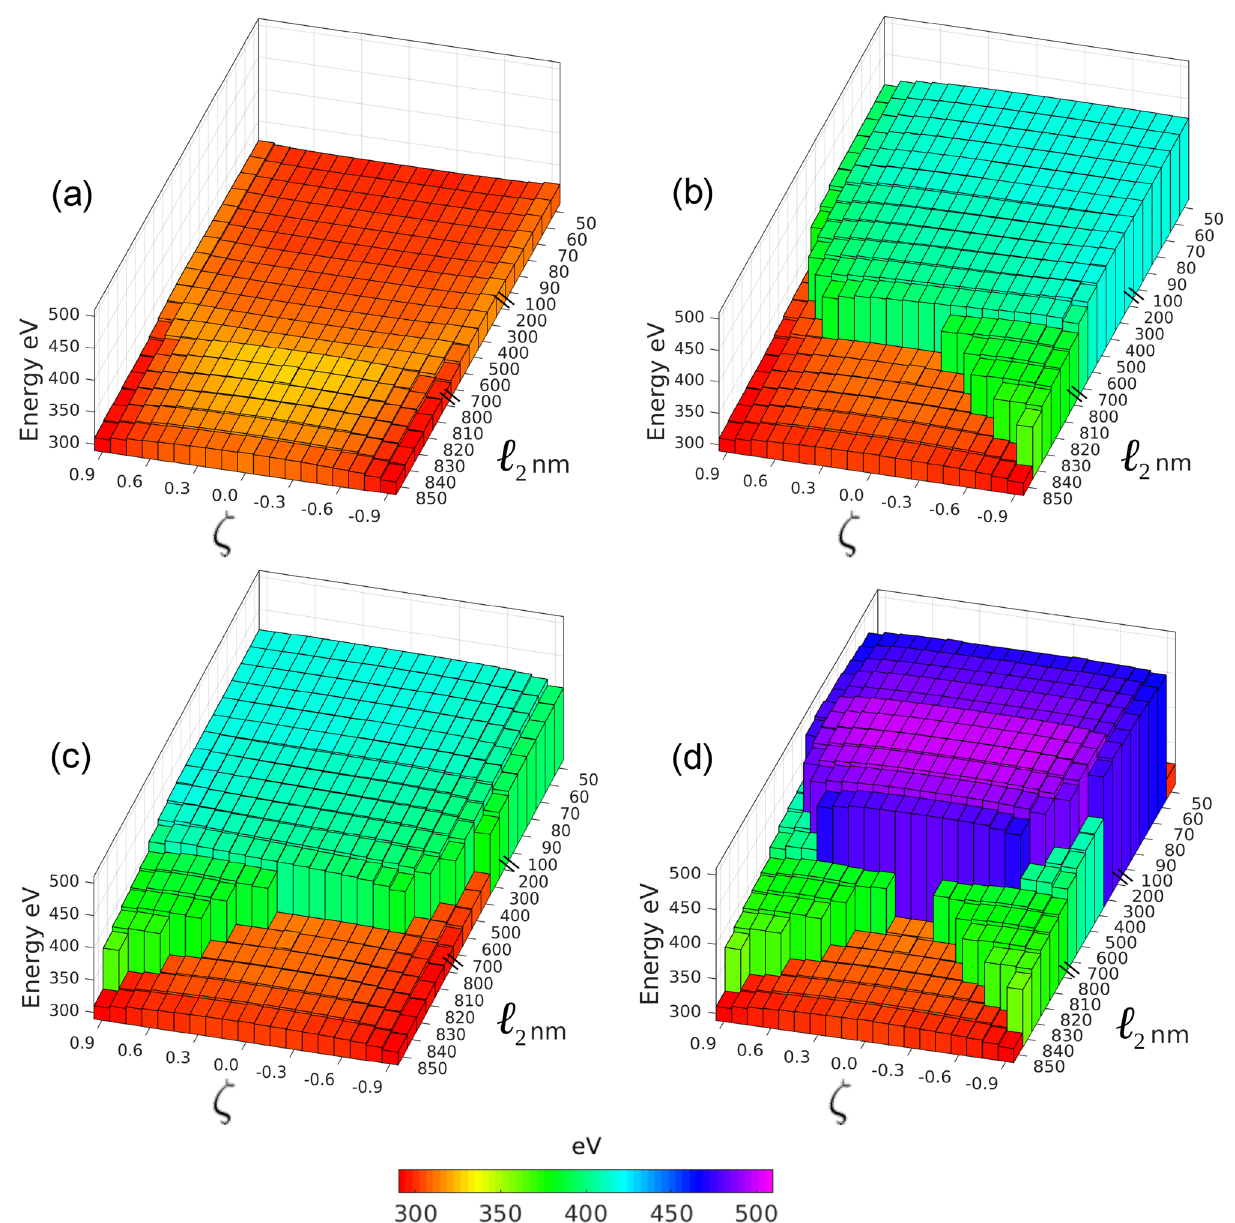
Figure 3. Energy phase diagram testing stability of the inscribed information. Each pixel represents a different ℓ 1 , ℓ 2 and ℓ 3 (through ζ ) choice and the height gives the corresponding equilibrium or final energy. Panel (a) illustrates the equilibrium energy for an original configuration C 1 inscribed in the system: obviously here it remains in the true ground C 1 configuration although the final energy landscape is not flat. Panel (b) corresponds to a C 2 configuration initially inscribed in the system represented by light gray (blue/green) color; however, for some geometries this initial configuration is unstable and decays to C 1 represented by the corresponding gray (orange) color and lower energies. Panel (c) , with C 3 originally inscribed, is symmetric to panel (b) with respect to the sign of ζ . Panel (d) represents systems initiated as C 4 configuration; those remaining as C 4 are marked in dark gray (blue/violet), but some of them are not stable and spontaneously decay to C 2 or C 3 for large enough ℓ 2 values and not very small | ζ | as represented by light gray color (blue/green); configurations with both large values of ℓ 2 and small | ζ | can collapse directly into C 1 configurations as presented by pixels in gray (orange)